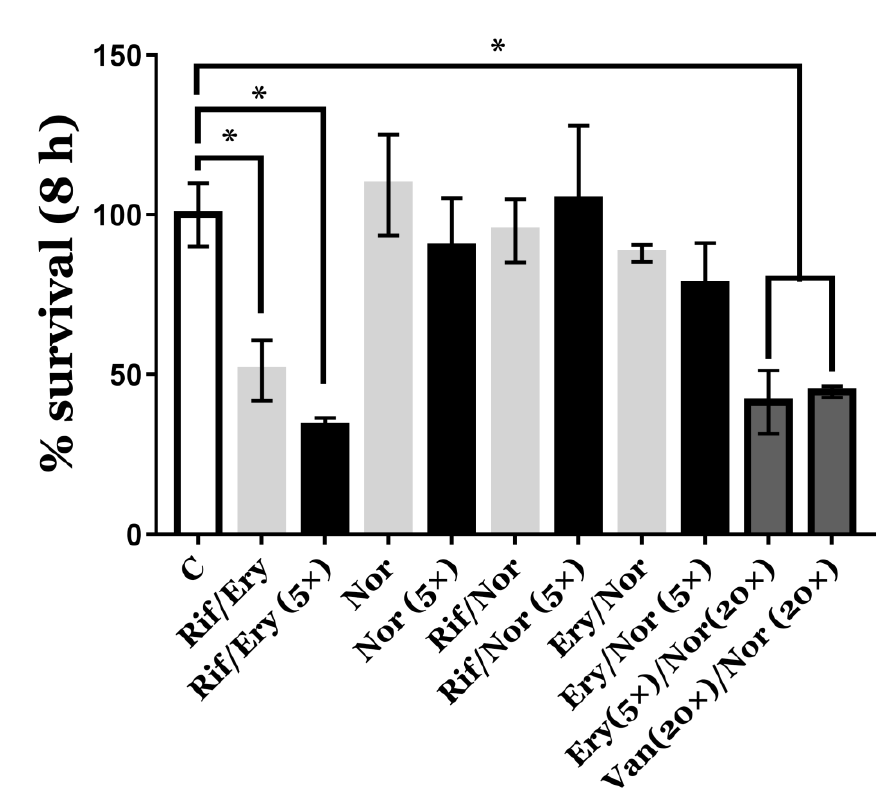
Figure 4. Antimicrobial e ff ect of di ff erent combinatorial antibiotherapies against intracellular R. equi 103S + infecting J774.A1 murine macrophages. Percentages of survival were quantified after 8 h of infection. Di ff erent combinations of rifampicin (Rif), erythromycin (Ery), norfloxacin (Nor),